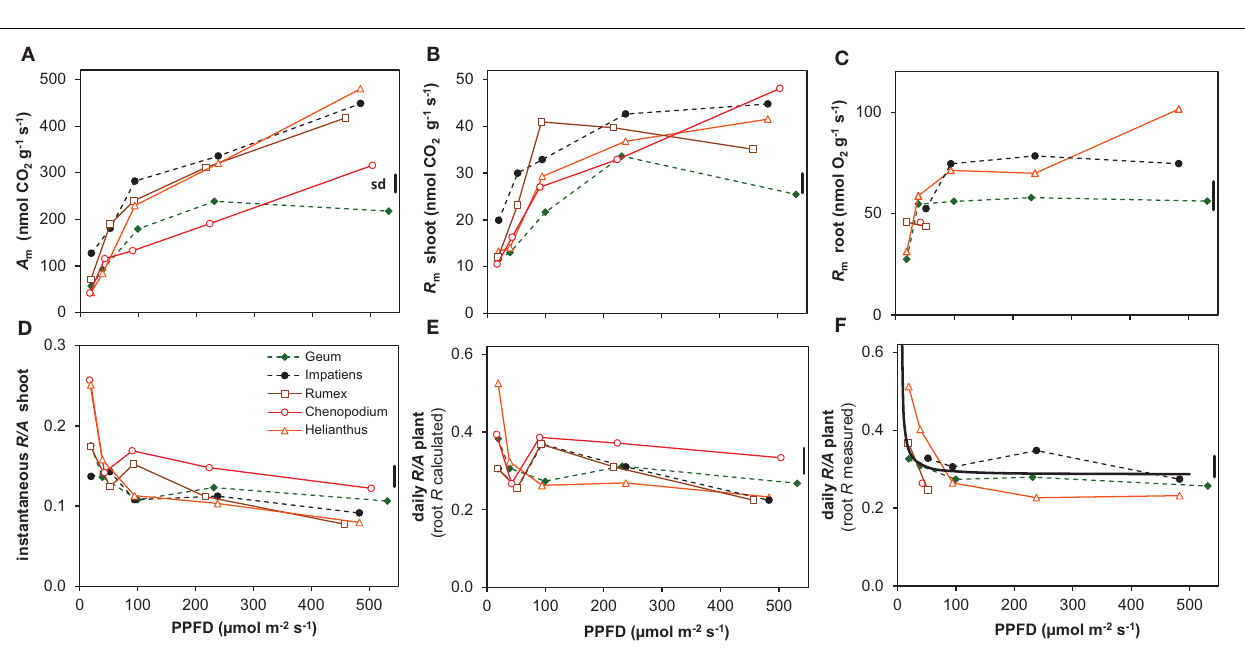
FIGURE 4 | Photosynthesis per unit leaf area ( A a ) of five species grown at five irradiance levels (PPFD). (A) Net photosynthesis per unit leaf area of whole shoots measured at growth irradiance ( A growth ); (B) light-saturated rate